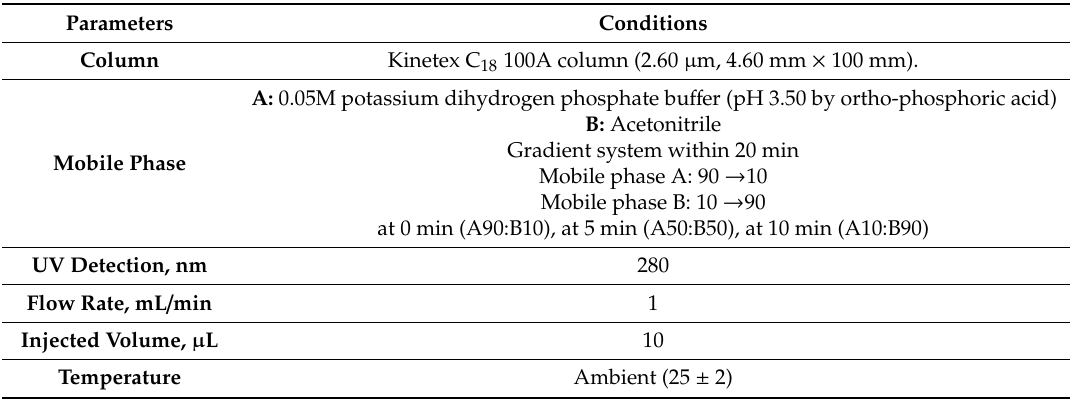
Table 1. Chromatographic conditions for the proposed